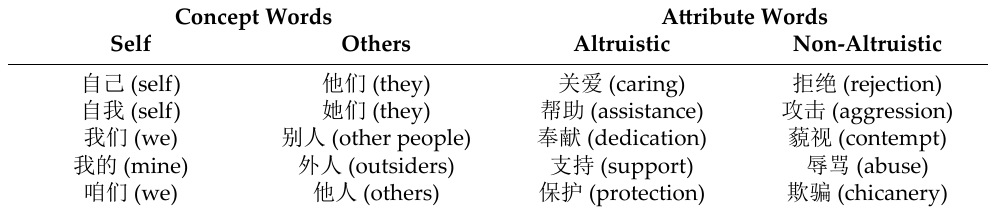
Table 2. The concept words and attribute words in